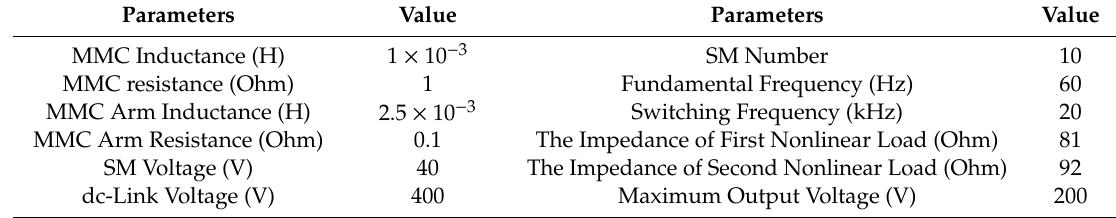
Table 1. The parameters of the proposed MMC in load change conditions.